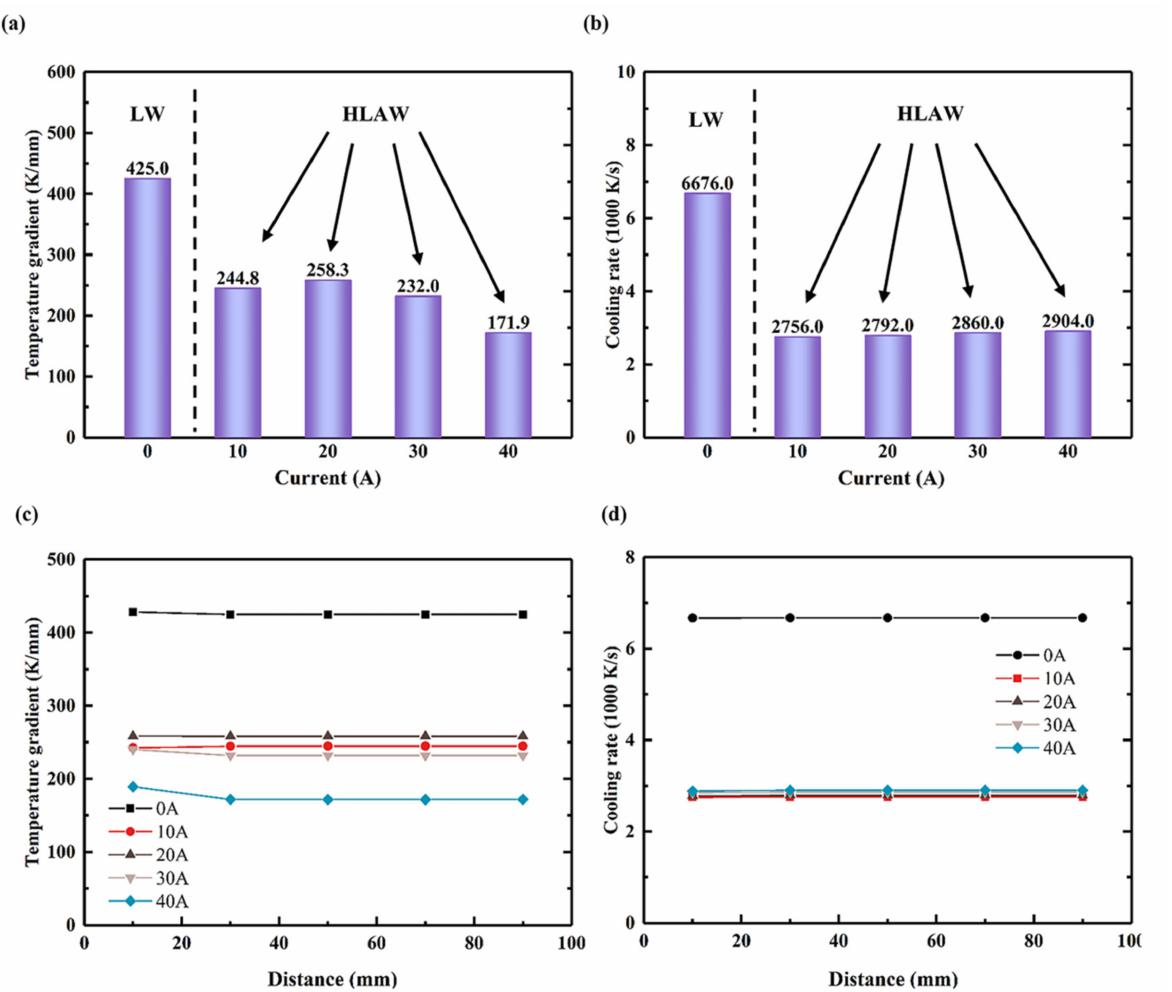
Figure 9. Temperature distribution with different currents at special points. ( a ) Maximum temper- ature gradients at special points (50, 0, 1). ( b ) Maximum cooling rate at special points (50, 0, 1). ( c ) Maximum temperature gradients at special points ( x , 0, 1). ( d ) Maximum cooling rate at special points ( x , 0,